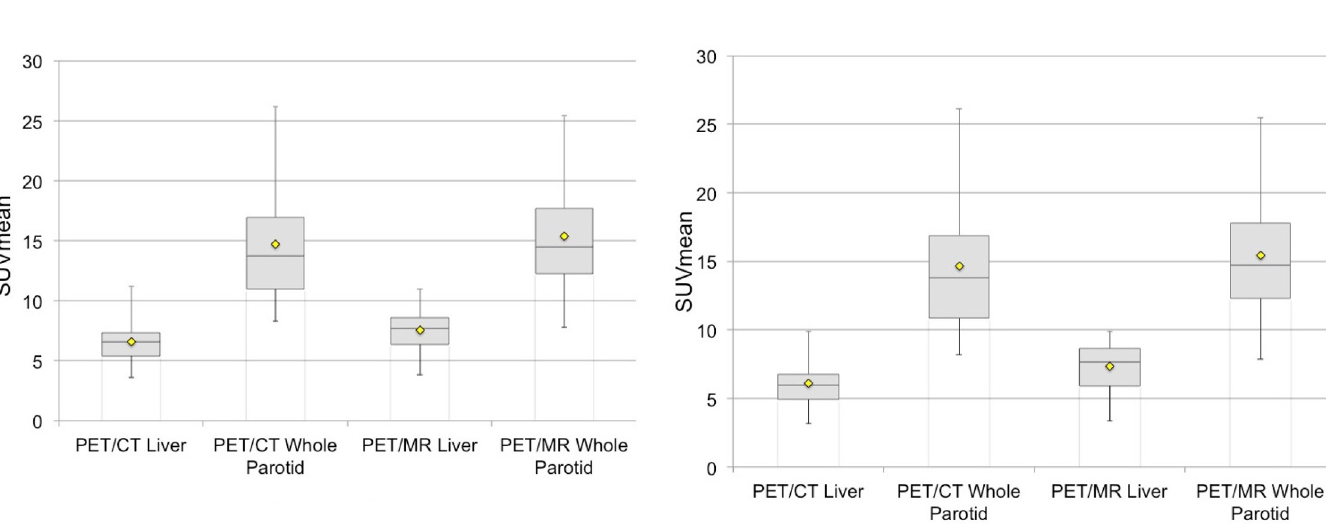
metastases, this might serve as an appropriate standard to evaluate for sites of possible meta- static disease. When comparing modalities, blood pool SUV was lower while liver and parotid gland mean were higher, although the absolute bias/increase was low (0.45–1.28) for the wbPET/MR com- pared to wbPET/CT. These differences were likely attributed to study design as the wbPET/ MR was acquired approximately 120 minutes after the [ 18 F]DCFPyL tracer injection whereas wbPET/CT was obtained 60 minutes after injection. This is supported by the work of Ferreira et al., which found a weak positive correlation between liver SUV and [ 18 F]DCFPyL uptake peak time [27]. A similar finding was seen in a study using [ 68 GA]PSMA [37]. Randomization of